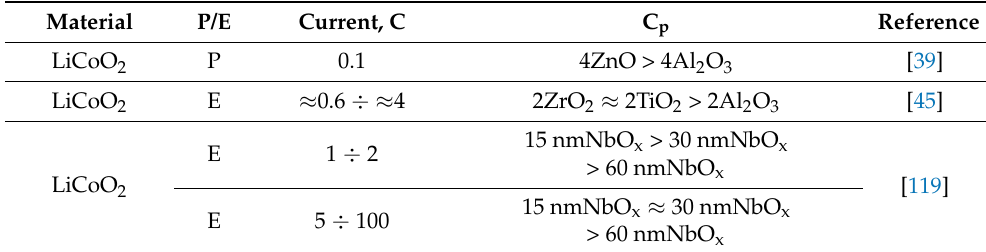
Table 6. Effect of coating selection on the capacity of active cathode materials in charge-discharge with different